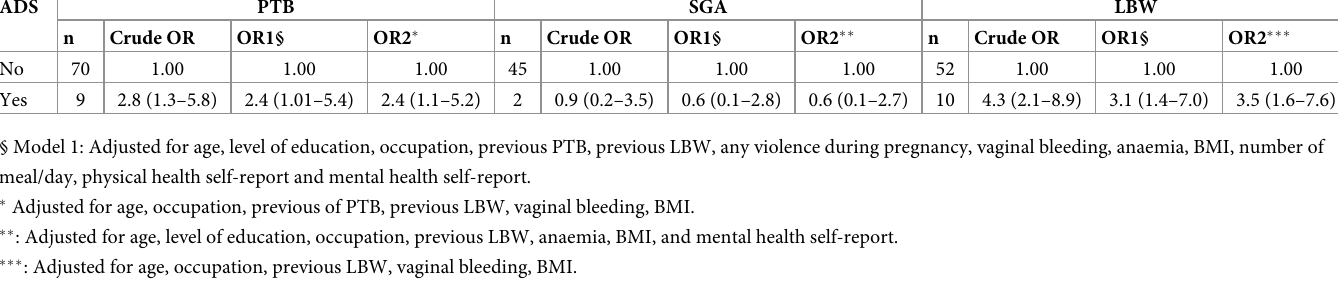
Table 3. Associations between ADS and preterm birth (PTB), small for gestational age (SGA), and low birth weight (LBW).